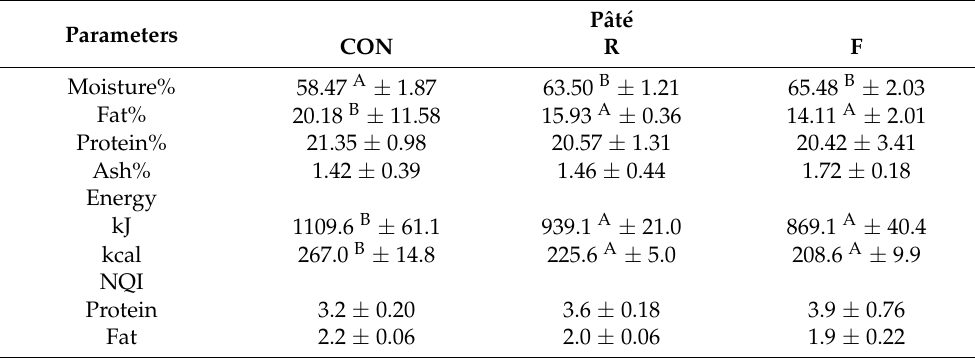
Table 3. Proximate composition, calorific value, and nutritional quality index (NQI) for protein and fat of pork p â t é s (mean ±